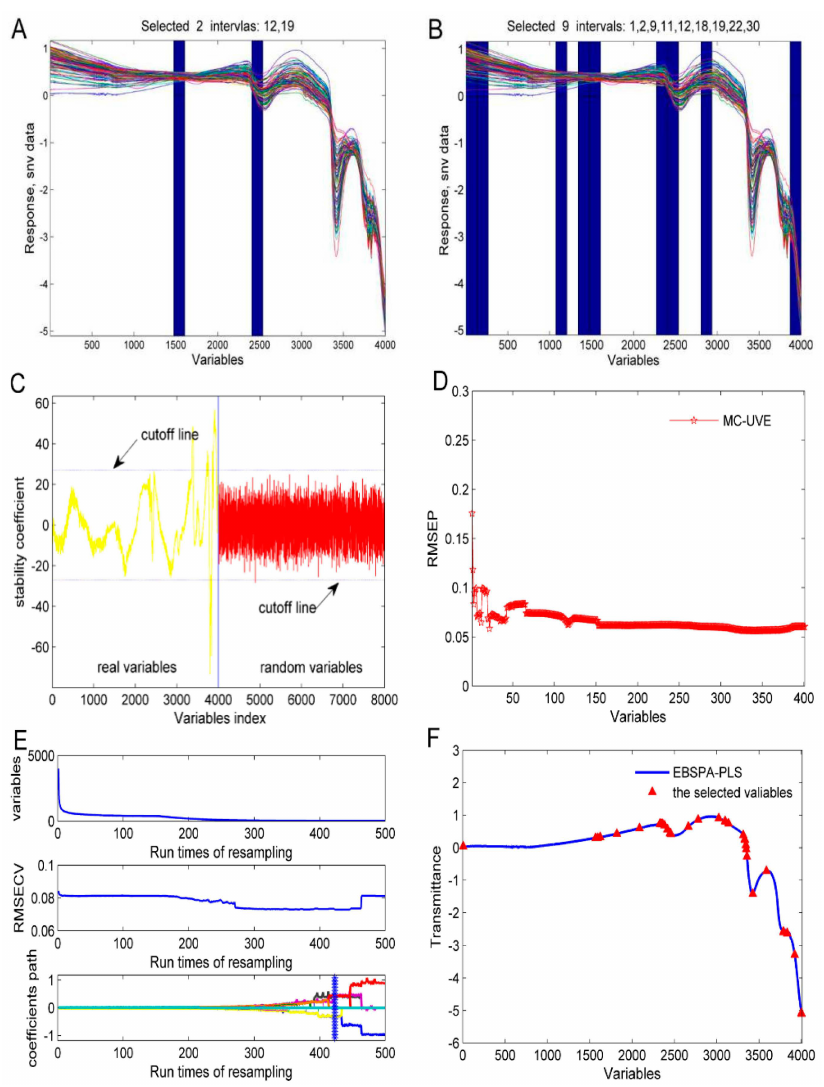
Figure 5. Variable selection: ( A ) FiPLS; ( B ) BiPLS; ( C ) UVE; ( D ) MC-UVE; ( E ) CARS; and ( F )